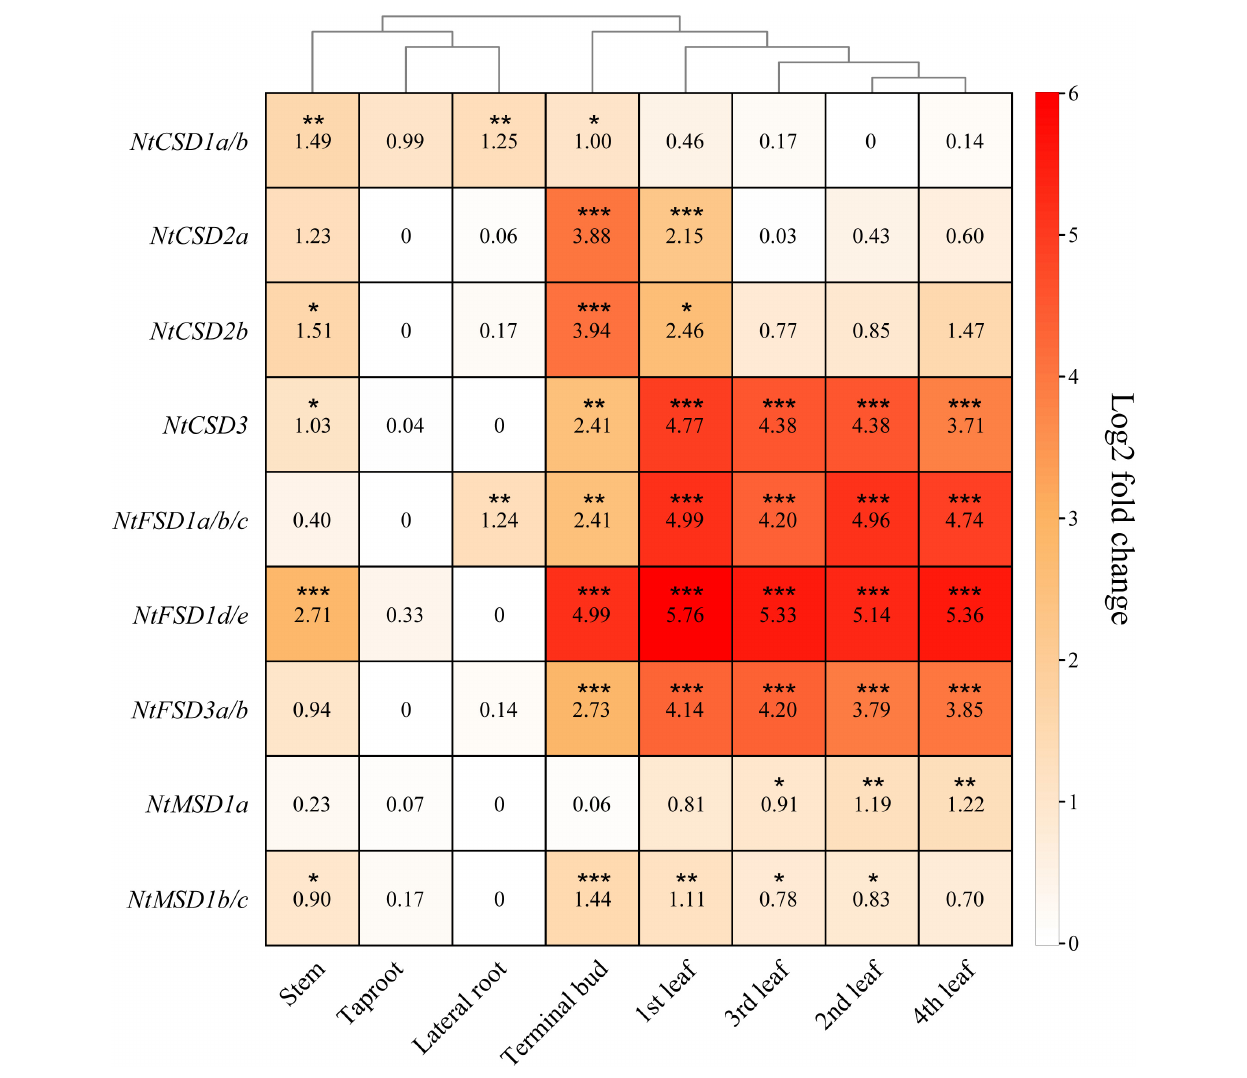
FIGURE 6 | The relative expression levels of NtSOD genes in different tobacco tissues. The expression data were obtained from the real-time RT-PCR (RT-qPCR) analysis data and are shown as log2 values calculated as averages. High expression levels are shown in red, and lower expression levels are shown in white. Statistically significant differences are indicated using asterisks (Dunnett’s test, * p < 0.05, ** p < 0.01, and *** p < 0.001). Data are presented as the means ± SD of three